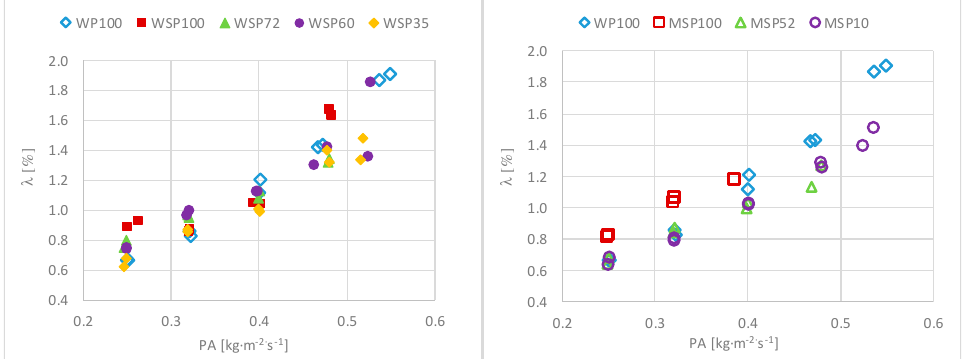
Figure 3. Values of λ for the different primary air studied. Comparison between the WP100 and WSP family ( left ) and the MSP family ( right ).